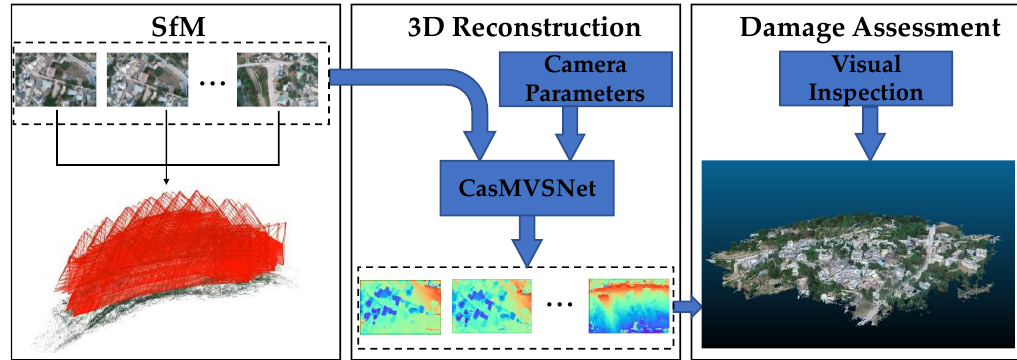
Figure 2. Workflow of building damage classification based on 3D model.